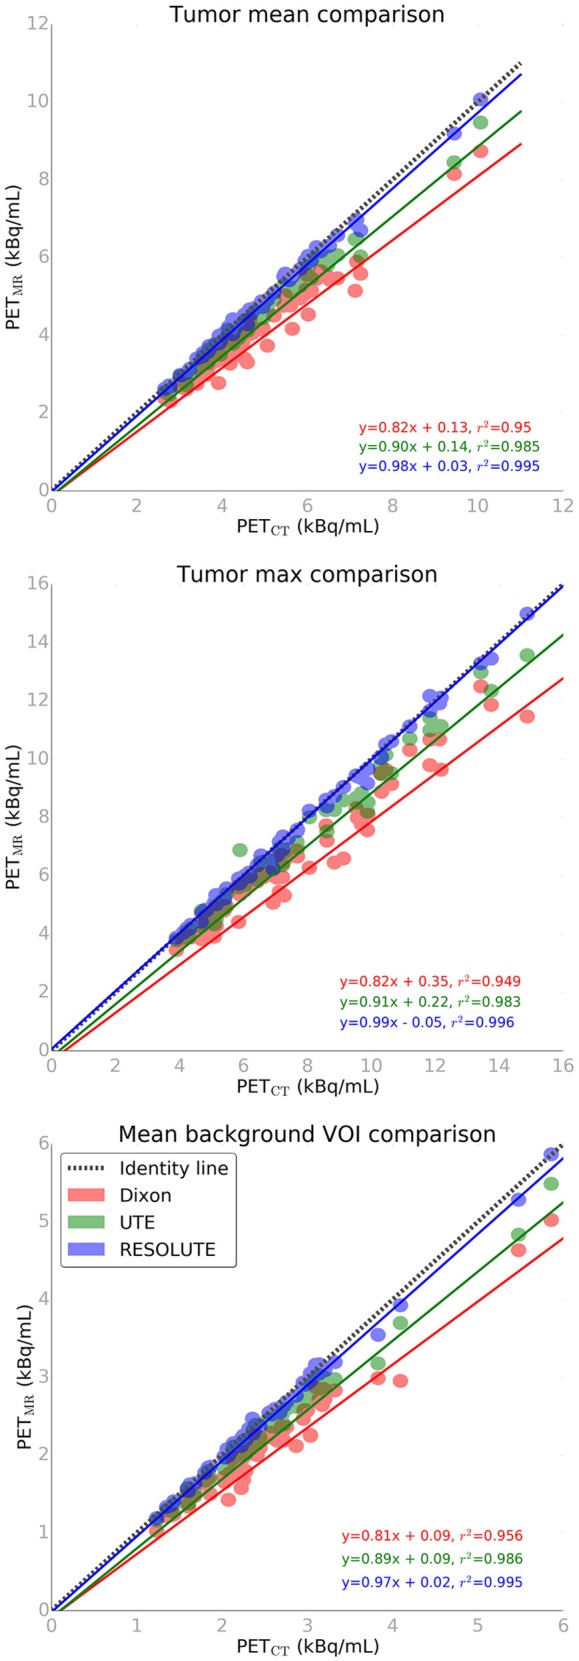
FET-PET tissue activity concentration plot for max tumor (top), mean tumor (middle), and mean background (bottom) values from 3 attenuation correction methods vs. CT reference standard.